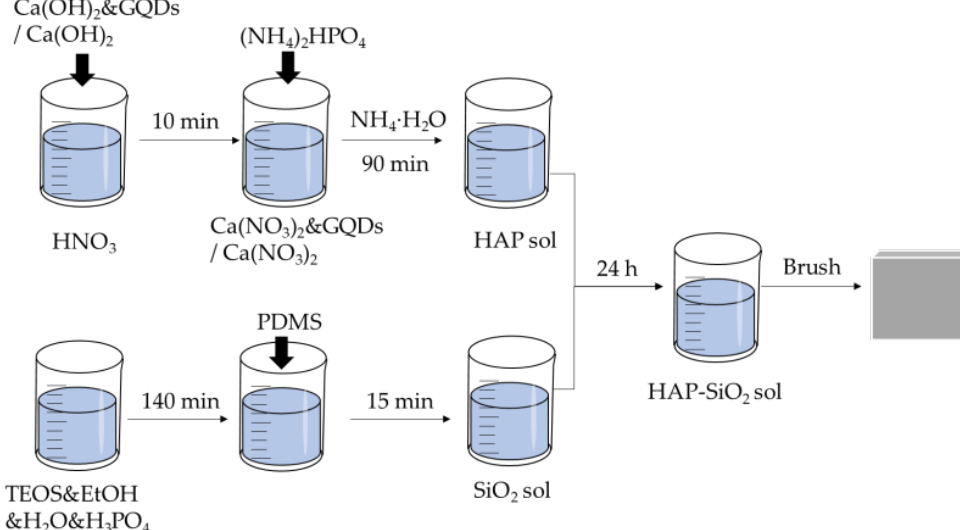
Figure 1. Preparation process of HAP film.